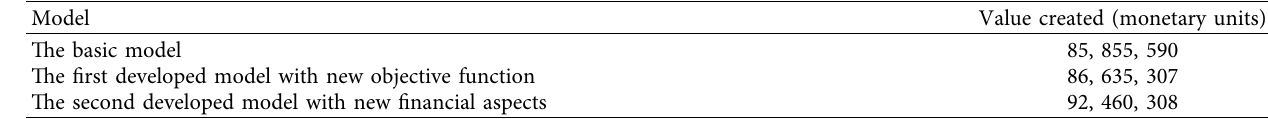
Table 9: Values obtained by each